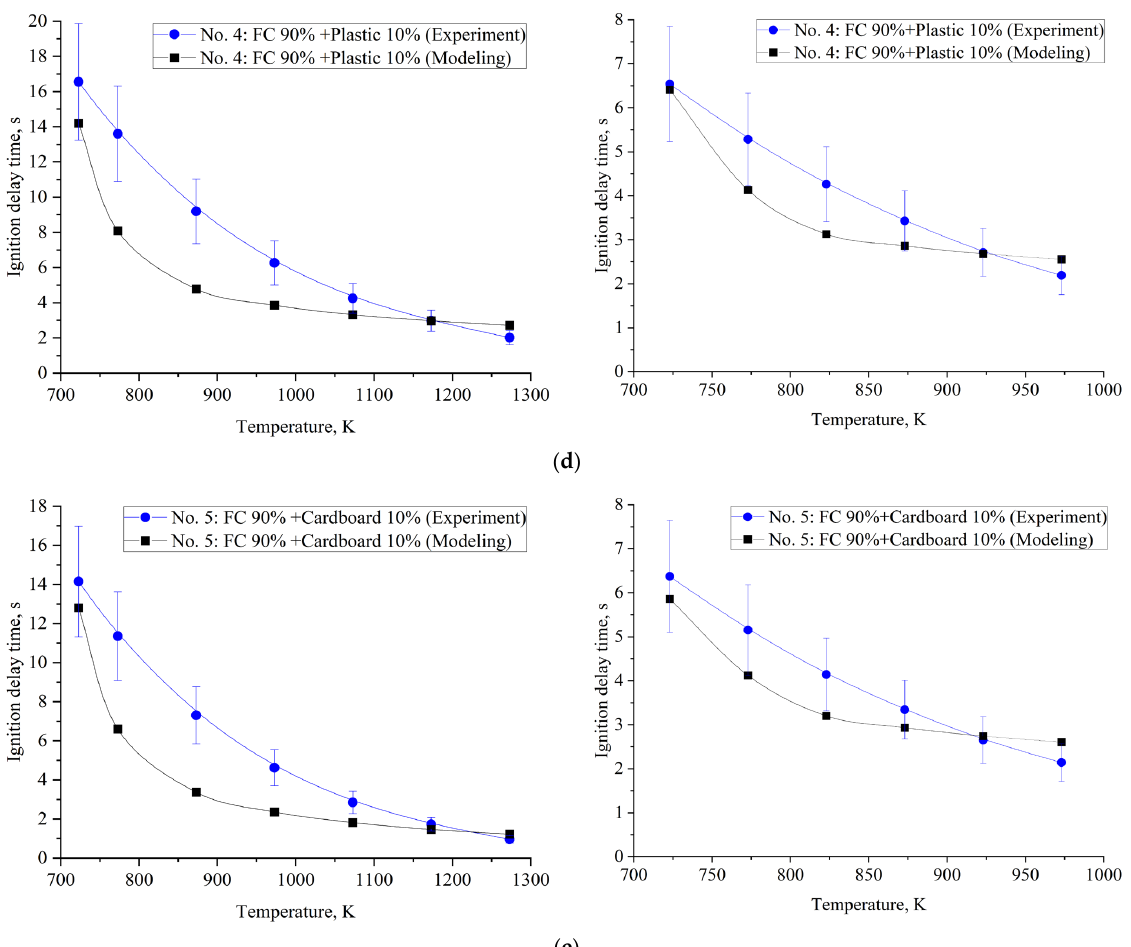
Figure 10. Ignition-delay times vs. heating source temperature at V g = 0 (left side) and V g = 3 m/s (right side) for CLF particles of different compositions: ( a ) No. 1 (FC 100%); ( b ) No. 2 (FC 90% + wood 10%); ( c ) No. 3 (FC 90% + rubber 10%); ( d ) No. 4 (FC 90% + plastic 10%); ( e ) No. 5 (FC 90% + cardboard 10%).